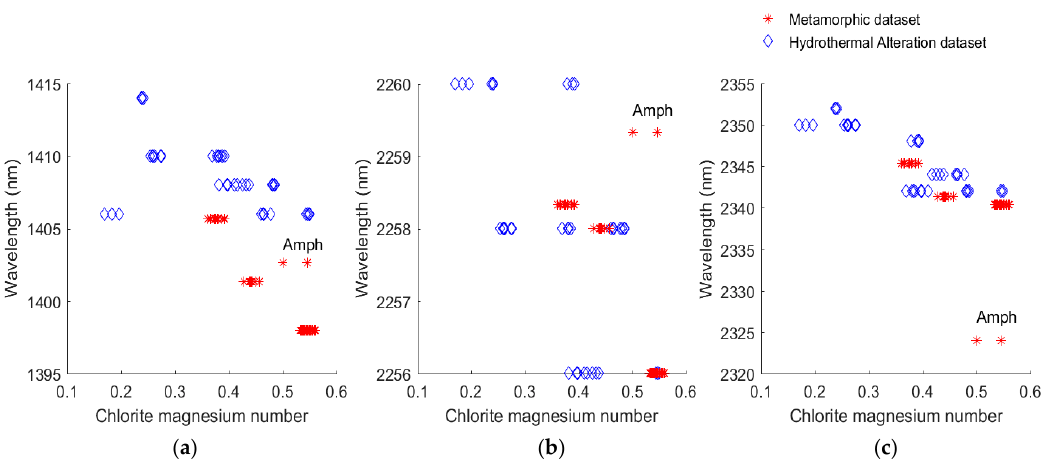
Figure 4. Comparison of the absorption wavelengths ( y -axis) of chlorite specific absorption features and the magnesium number of chlorite ( x -axis). ( a ) -OH absorption feature; ( b ) Fe-OH absorption feature; ( c ) Mg-OH absorption feature. “Amph” highlights measurements of the sample metamorphosed in the amphibolite facies.